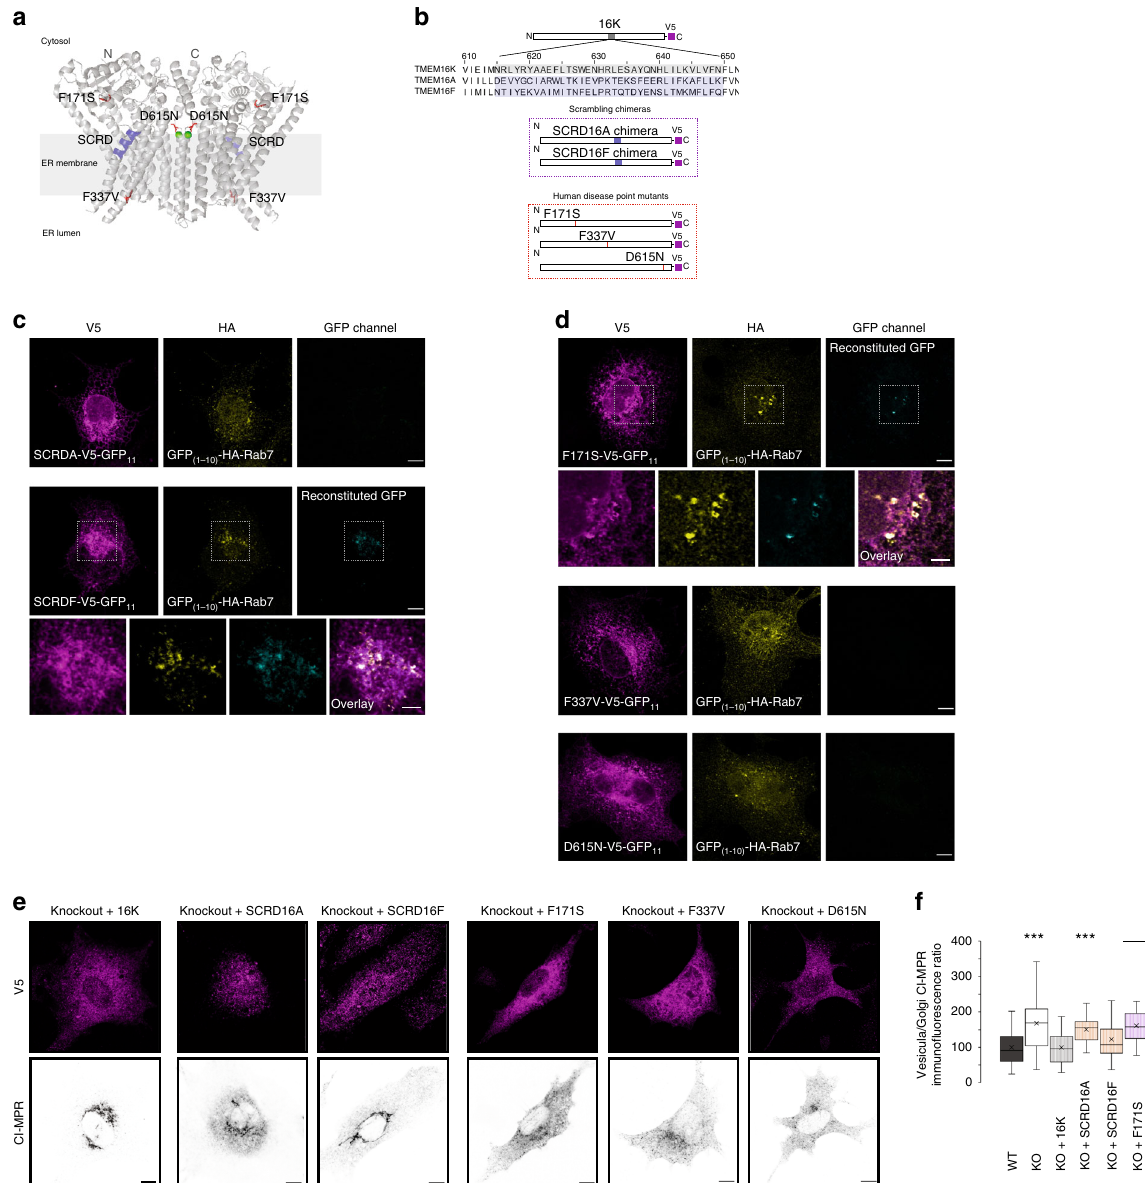
Fig. 8 TMEM16K scrambling domain chimeras and human disease variants. a Topology of TMEM16K dimer in the endoplasmic reticulum membrane with labeled human disease point mutations and SCRD (minimal lipid scrambling domain) based on published crystal structure 33 and represented in Pymol. b Scheme of the SCRD chimeras and human disease point mutation constructs c Split-GFP reconstitution assay of scrambling domain chimeras (SCRDA, SCRDF) tagged with GFP 11 and GFP (1-10) tagged Rab7. Scale bar 10 µ m, inset 5 µ m. d Split-GFP reconstitution assay of human point mutants (F171S,